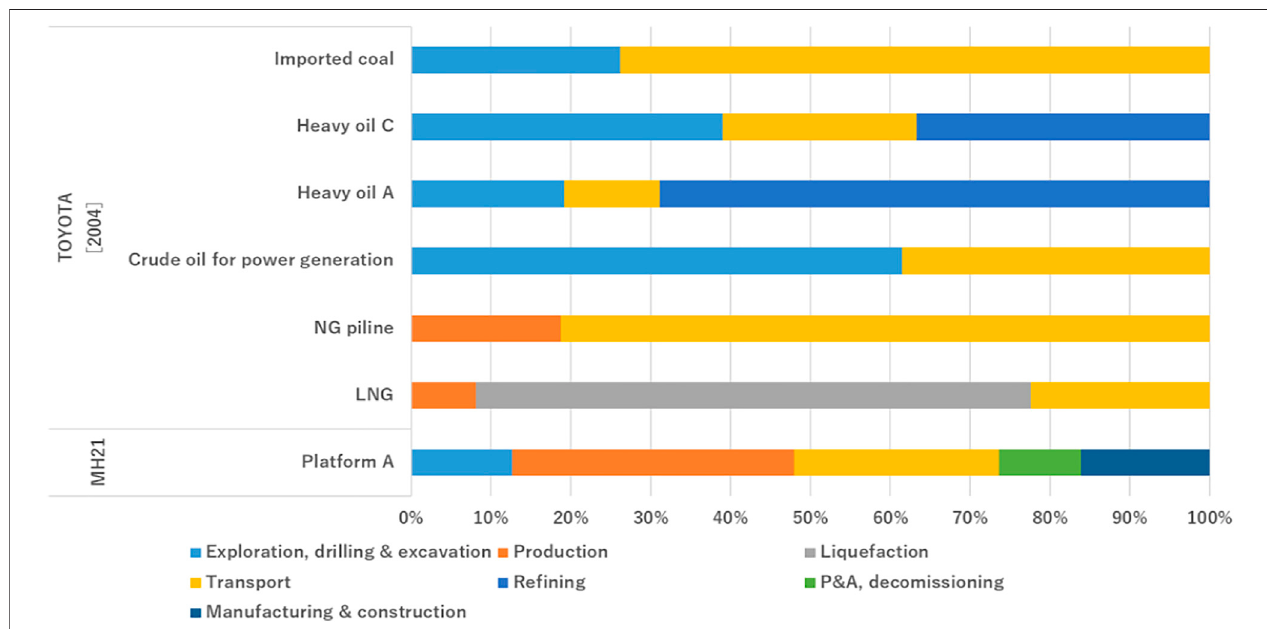
FIGURE 8 | Energy input structure to produce each energy (coal, heavy oil, crude oil, natural gas (NG), LNG imported to Japan, and gas hydrate with offshore platformoption).(ToyotaMotorCorporationandMizuhoInformationandResearchInstitute,Inc.,2004;ResearchConsortiumforMethaneHydrateResourcesinJapan,